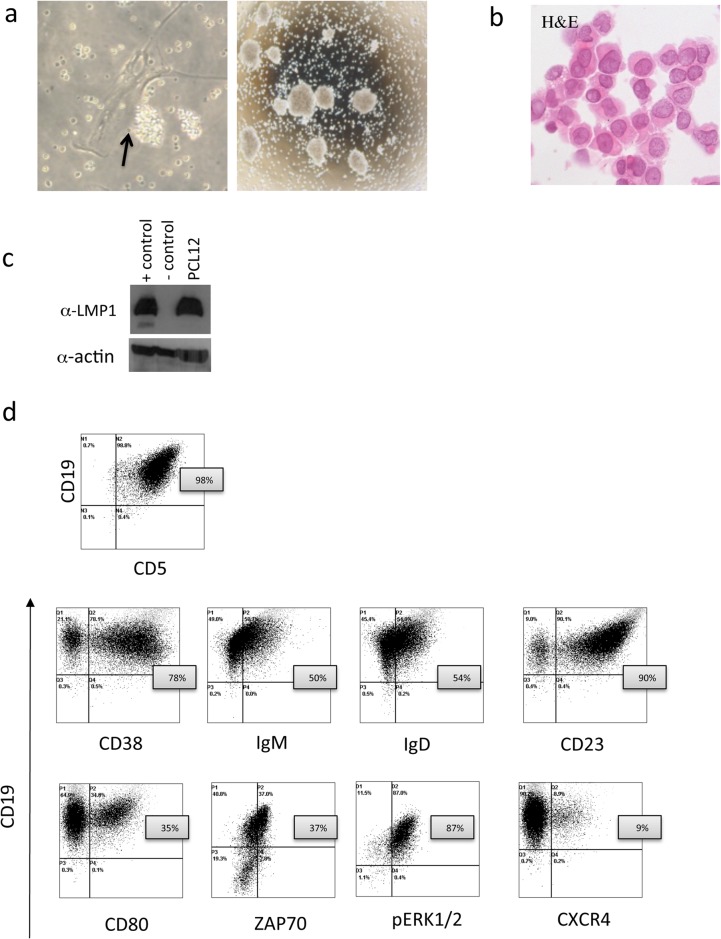
(a) PCL12 cells images acquired with Nikon TS100 microscope after 4 weeks of culture (20x magnification objective in the left panel), dark arrow indicating nurse like cells, and 6 weeks of culture (4x magnification objective on the right).(b) Haematoxylin and Eosin staining (c) WB analysis for LMP1 protein on PCL12 cells, Positive control JY cell line and negative RL cell line. (d) PCL12 immunophenotype dot plot acquired by Flow cytometry.